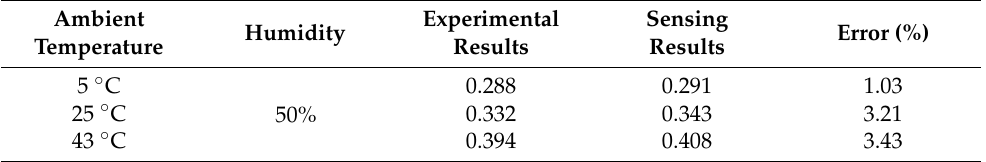
Table 3. Accuracy of the quality experiments using the quality sensor at evaporator inlet part.